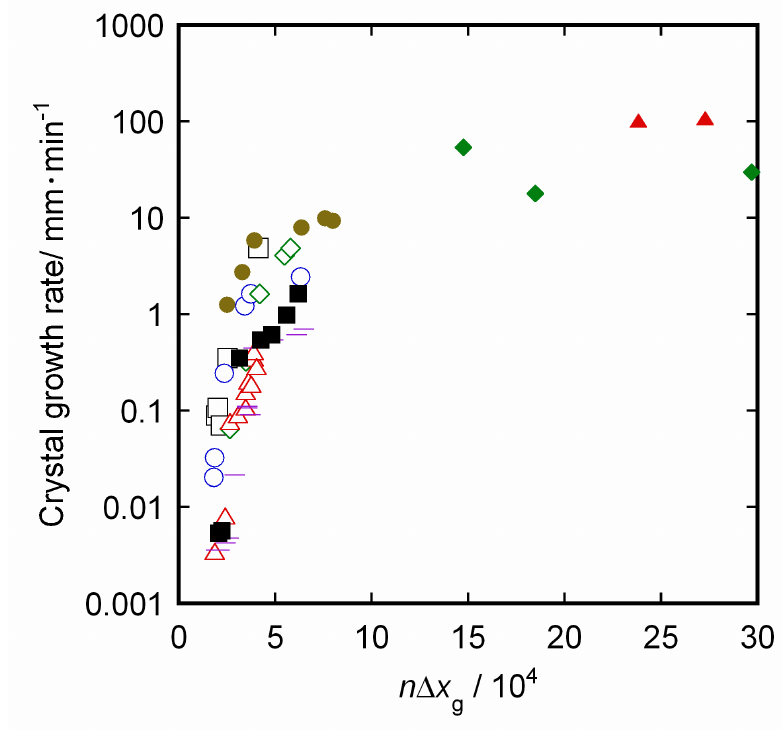
Figure 4. Dependence of hydrate-layer growth rate on the n ∆ x ( □ ) methane at 5.60 MPa [12]; ( ○ ) methane at 8.15 MPa [12]; ( ◇ ) methane at 10.56 MPa [12]; ( △ ) propane at 0.31 MPa [12]; ( － ) propane at 0.41 MPa [12]; ( ■ ) propane at 0.51 MPa [12]; ( ● ) methane [13]; ( ◆ ) CO ( ▲ ) CO (gas) at 5 MPa 2